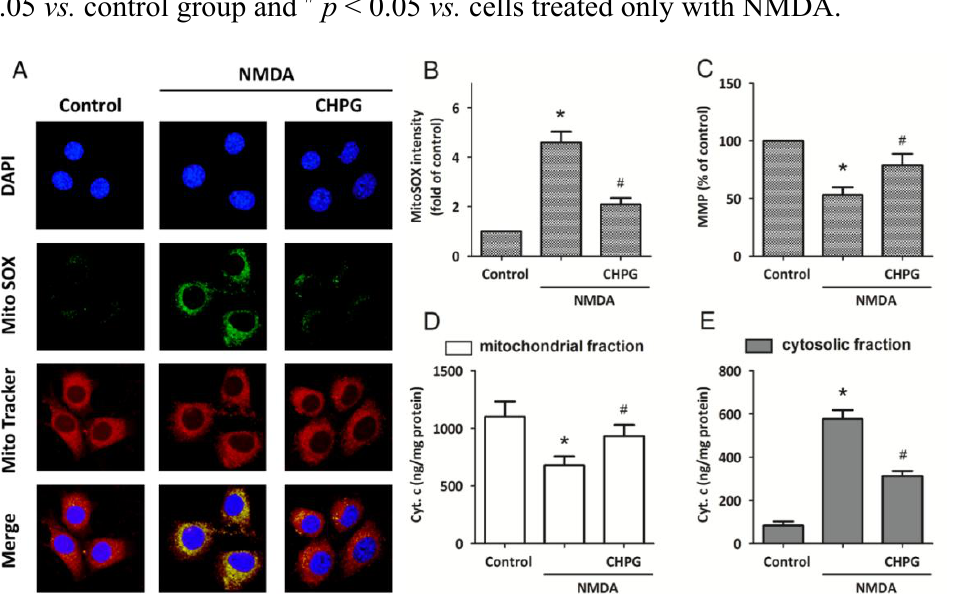
Figure 3. CHPG attenuates NMDA-induced mitochondrial dysfunction. Differentiated PC12 cells were treated with 100 μM NMDA alone or pretreated with 50 μM CHPG before NMDA treatment. ( A ) ROS (reactive oxygen species) generation in mitochondria was assessed by MitoSOX (green) and MitoTracker (red) staining, and MitoSOX intensity was calculated ( B ); The mitochondrial membrane potential (MMP) value was determined ( C ) and the expression levels of cytochrome c in mitochondrial fraction ( D ) and cytosolic fraction ( E ) were measured, respectively. Data represent means ± SD from five experiments.